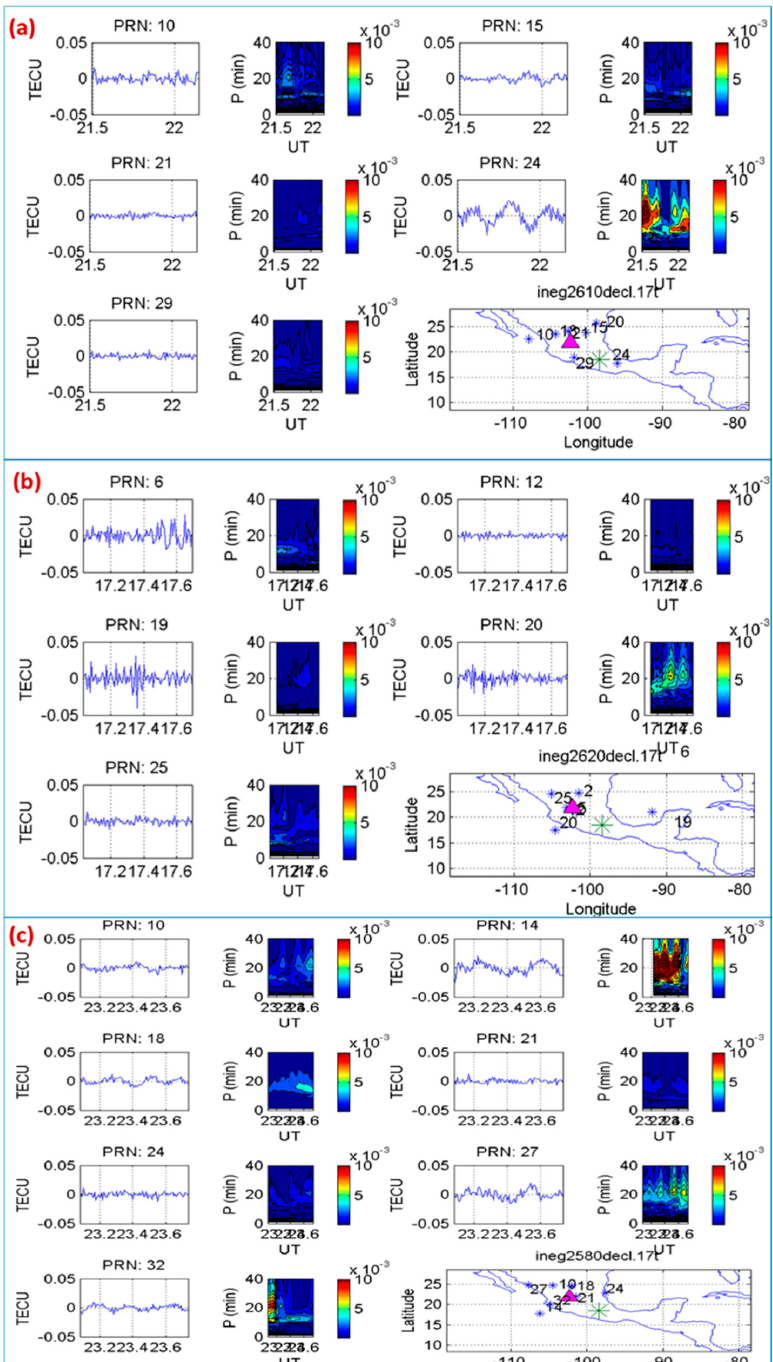
Figure 12. Fluctuations of differential slant TEC obtained from the INEG station and PRN satellites passing over the earthquake preparation area on: ( a ) 18 September 2017 (DoY 261) at 21.5–22.0 UT (upper panel), ( b ) 19 September 2017 (DoY 262) at 17.0–17.6 UT (middle panel) and ( c ) 15 September 2017 (DoY 258) at 23.0–23.6 UT (lower panel). Power spectrograms of normalized amplitude are also shown. Maps show earthquake epicenter (green asterisk), INEG station (pink triangle), number and position of satellite (blue asterisks).